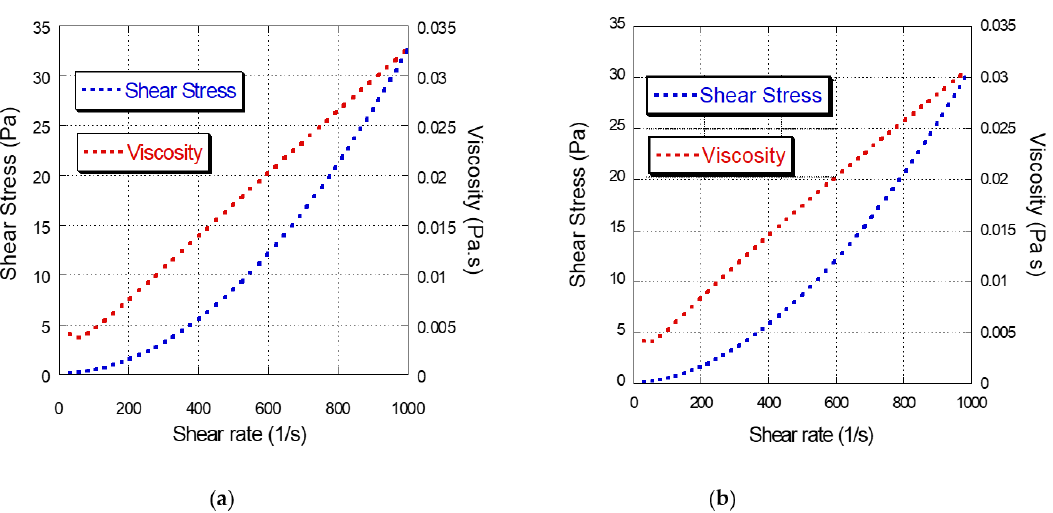
Figure 5. Rheogram of taro SFP at 25 °C at the two levels of starch concentration ( a ) 4.5 g and ( b ) 5.5 g.